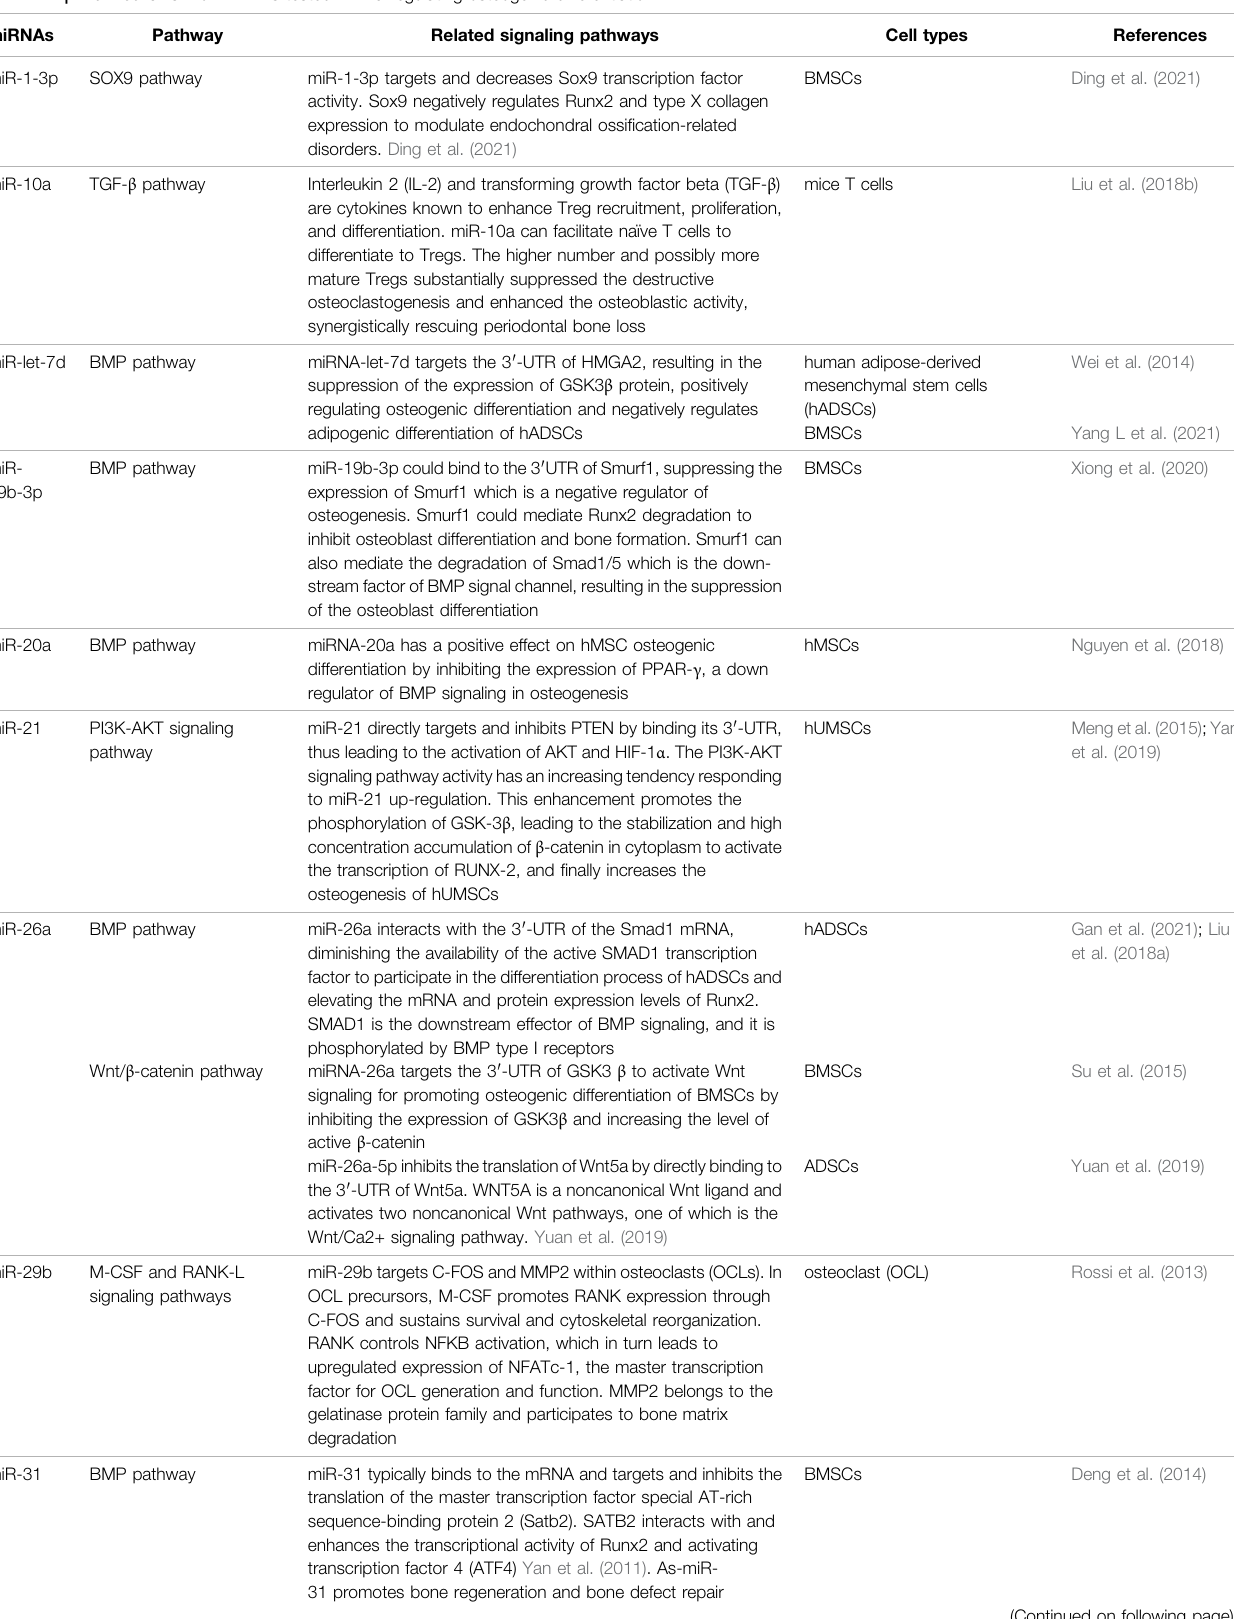
TABLE 2 | The mechanism of miRNAs tested in vivo regulating osteogenic differentiation.